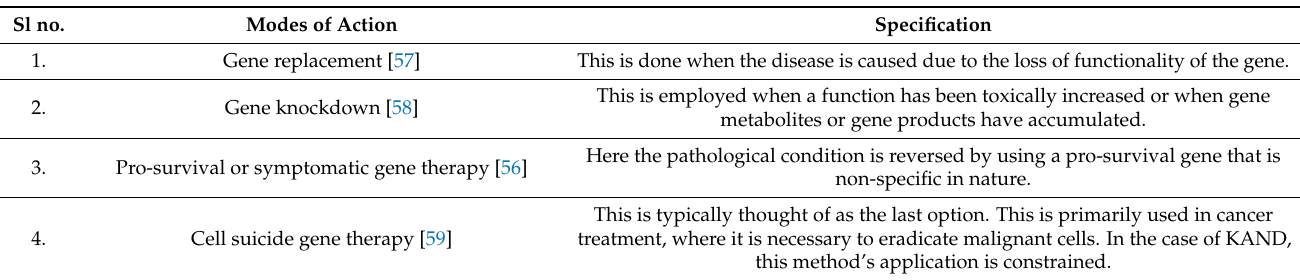
Table 1. The fundamental experimental approach for gene therapy used four theoretical modes of action